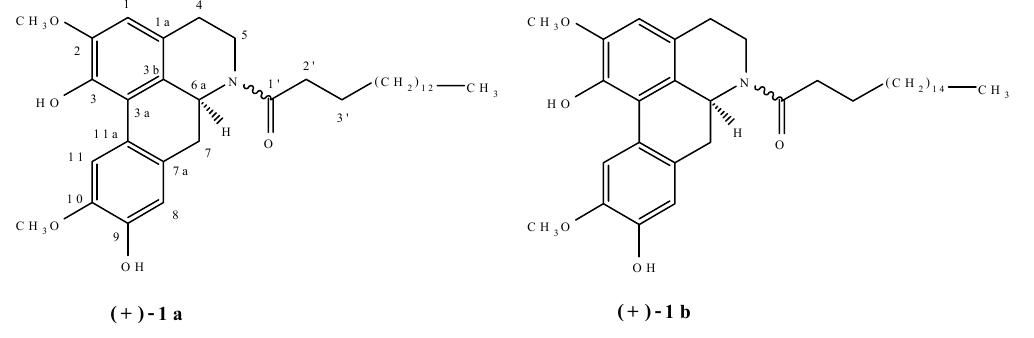
Figure 1. Structures of (+)-laurelliptinhexadecan-1-one ( 1 a) and (+)-laurelliptinoctadecan- 1-one ( 1b